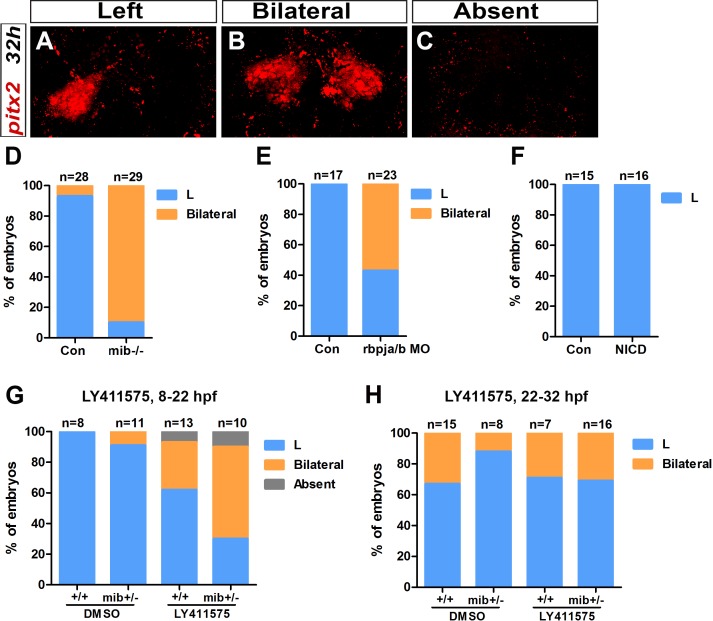
Early Notch loss-of-function results in bilateral Nodal pathway activation in the epithalamus.(A–C) Confocal sections showing Left (A), Bilateral (B) or Absent (C) pitx2c expression in the epithalamus at 32 hpf (red). Embryo view is dorsal, anterior is up; scale bar = 10 µm. (D–H) Histogram showing the percentage of embryos with Left (L, blue), Bilateral (orange) and Absent (gray) pitx2c expression in mib-/- mutant embryos (D), in rbpja/b morphant (MO) embryos (E), in embryos expressing NICD (Notch Intra-cellular Domain) (F) and in embryos treated with 30 µM of LY411575 from 8 to 22 hpf (G) or from 22 to 32 hpf (H). Genetic background, treatment and embryos numbers are indicated below each bar; Con: control sibling embryos. Data are representative of two (D–F) or one experiment (E, G, H).